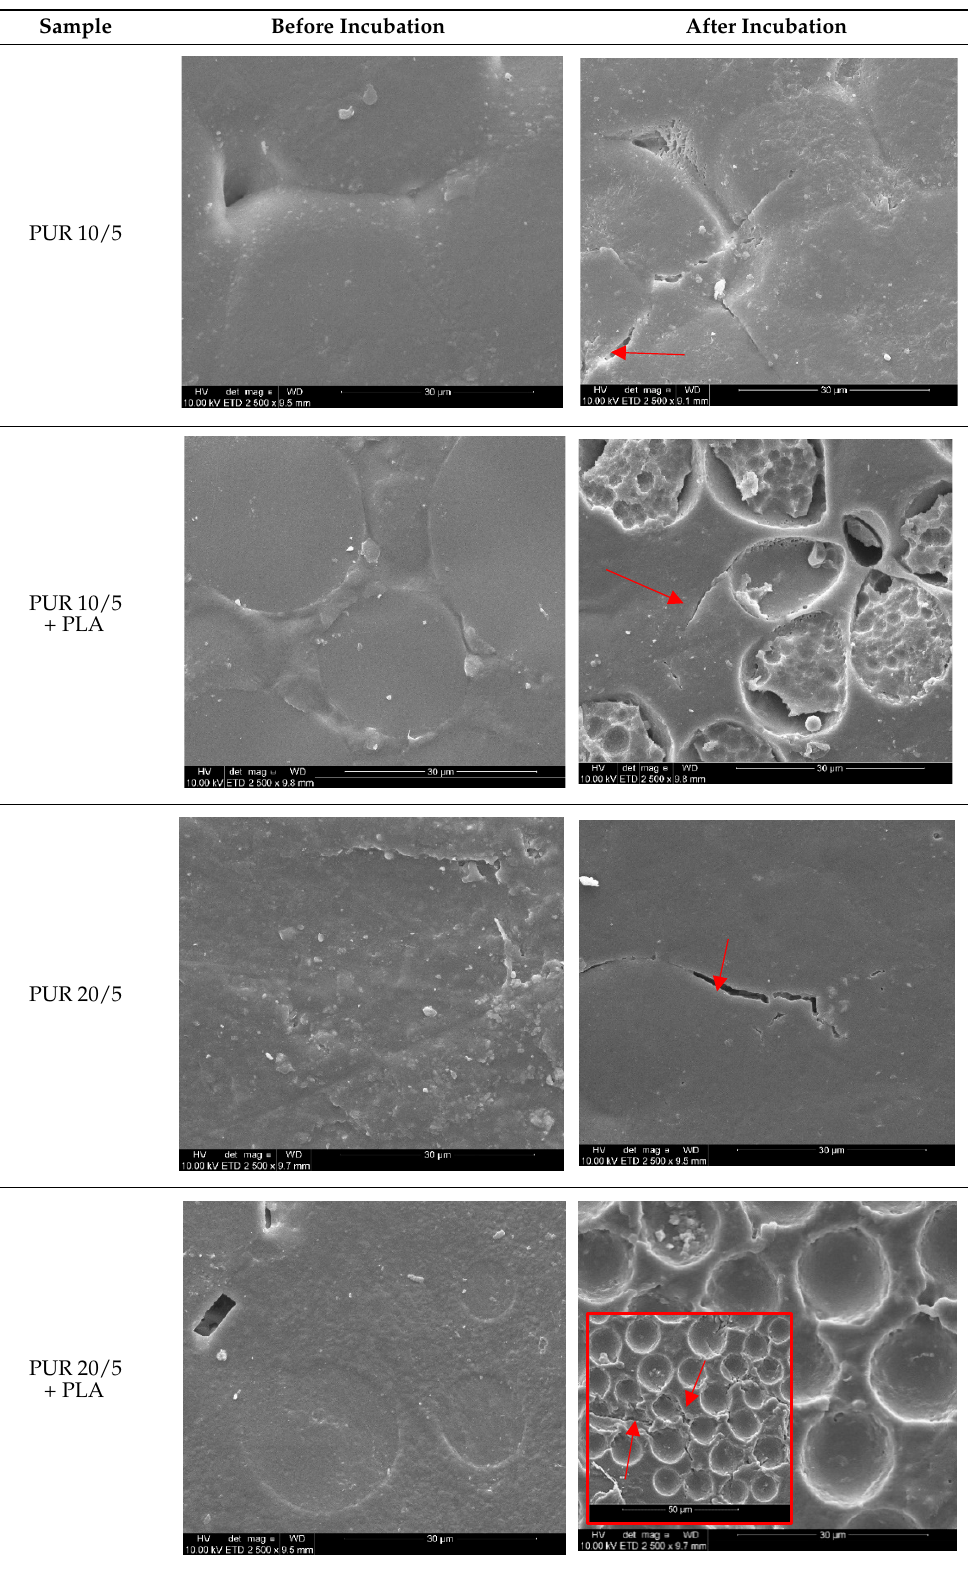
Table 4. SEM images of the surface of PUR samples and their blends before and after 36 weeks of Table 4 . SEM images of the surface of PUR samples and their blends before and after 36 weeks of Table 4 . SEM images of the surface of PUR samples and their blends before and after 36 weeks of Table 4 . SEM images of the surface of PUR samples and their blends before and after 36 weeks of Table 4 . SEM images of the surface of PUR samples and their blends before and after 36 weeks of exposure to soil. exposure to soil. exposure to soil. exposure to soil. exposure to soil.